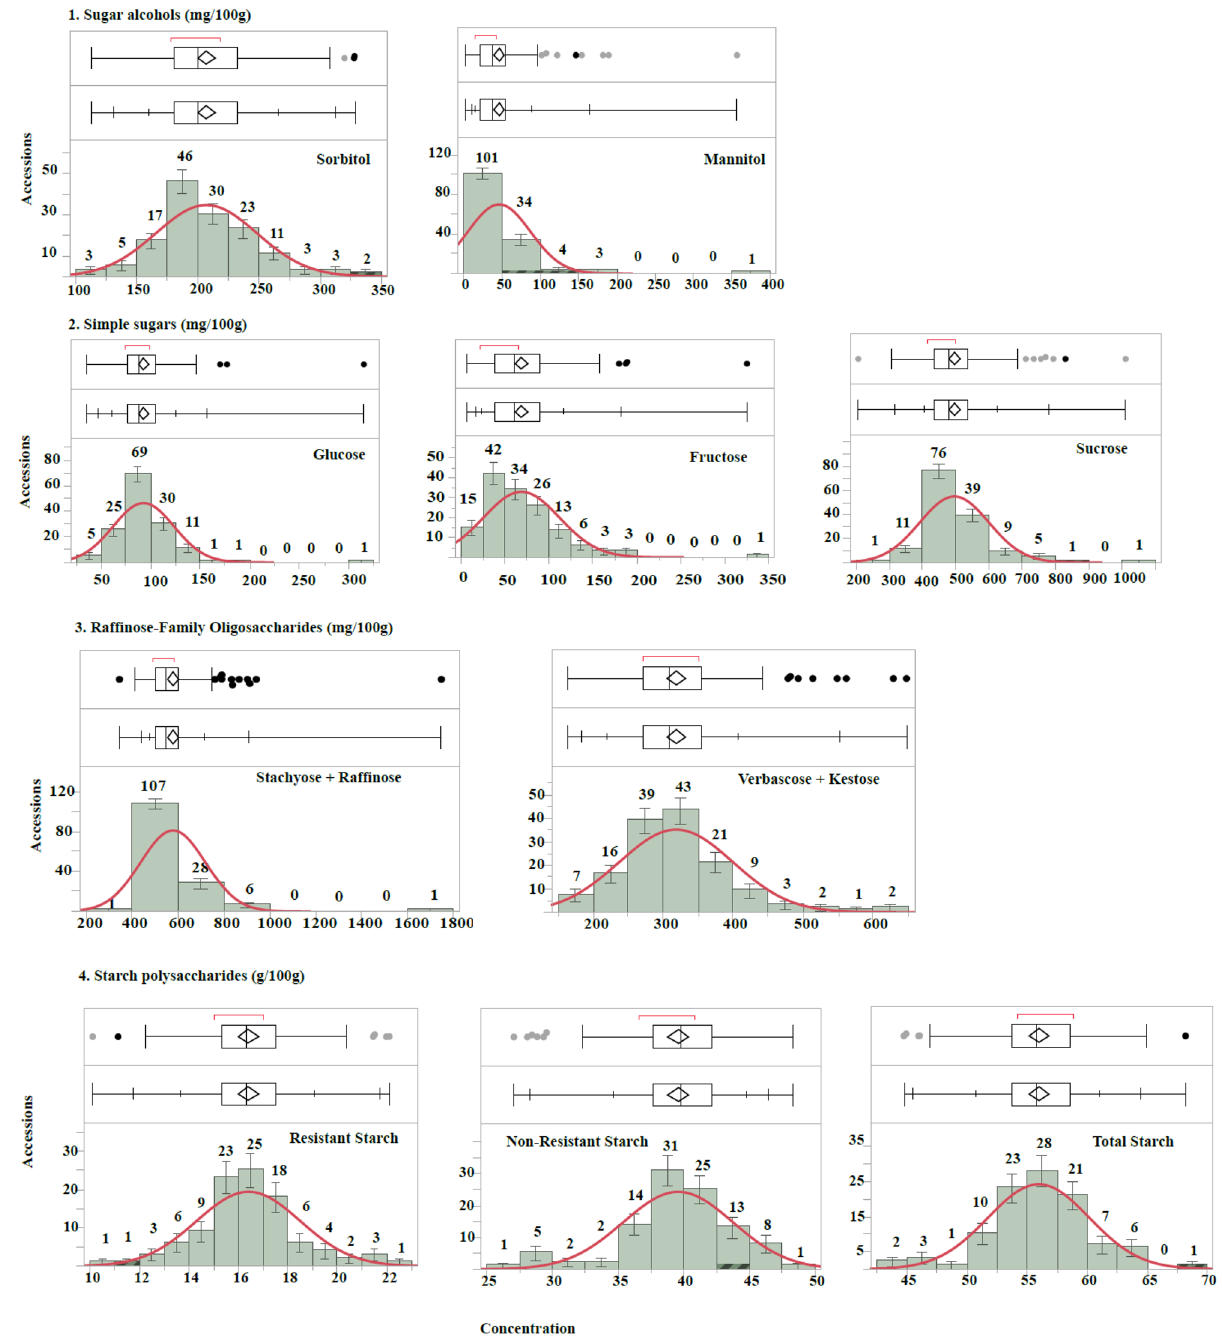
Figure 1. Histograms of accession means with normal curve fits. 1. Sugar alcohols (mg/100 g); Simple sugars (mg/100 g); Raffinose-family oligosaccharides (mg/100 g); starch polysaccharides (g/100 g). The first box plot (Tukey outlier) shows possible outliers as points, while the second box plot (normal quantile) includes all data in estimates. Red normal curves were fitted to the data based on the mean, standard deviation, and sample